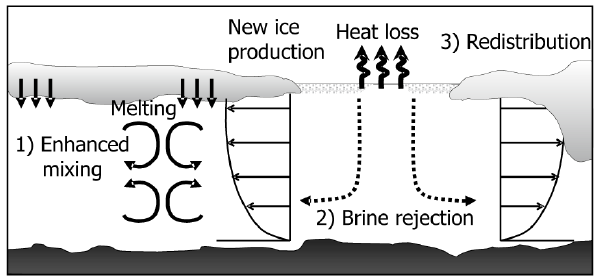
Fig. 1. Schematic highlighting the interaction between sea ice and